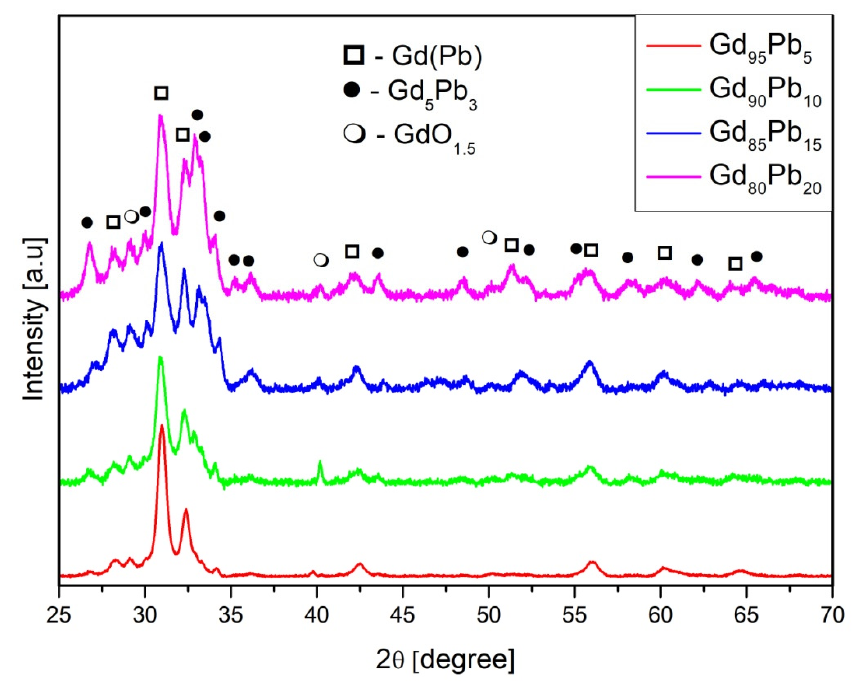
Figure 2. X-ray diffraction pattern for the Gd 100 − x Pb x (where x = 5, 10, 15, 20) alloys. Table 1. The results of the Rietveld analysis.